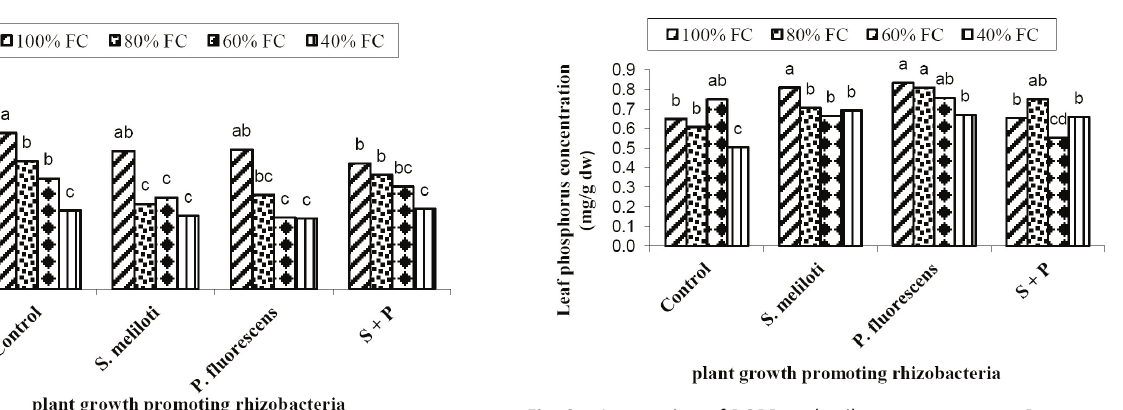
fig. 6 - Interaction of PGPR and soil water content on P concen- tration of fenugreek shoot.